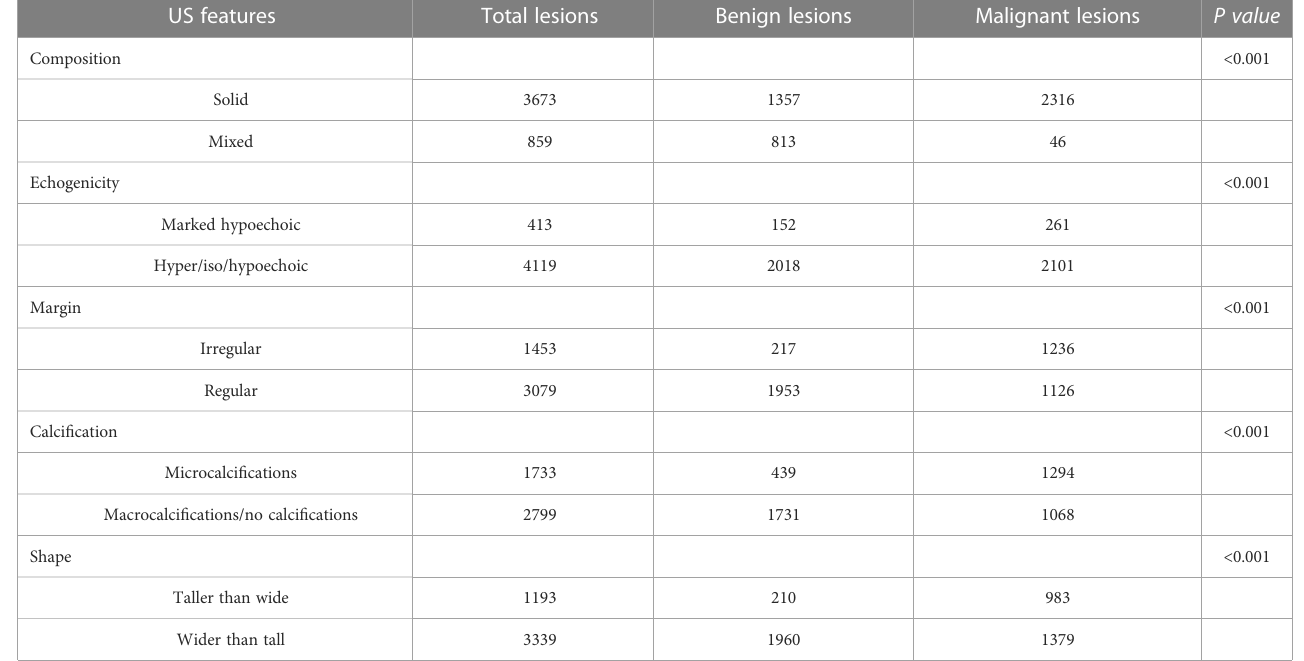
TABLE 2 US features of thyroid